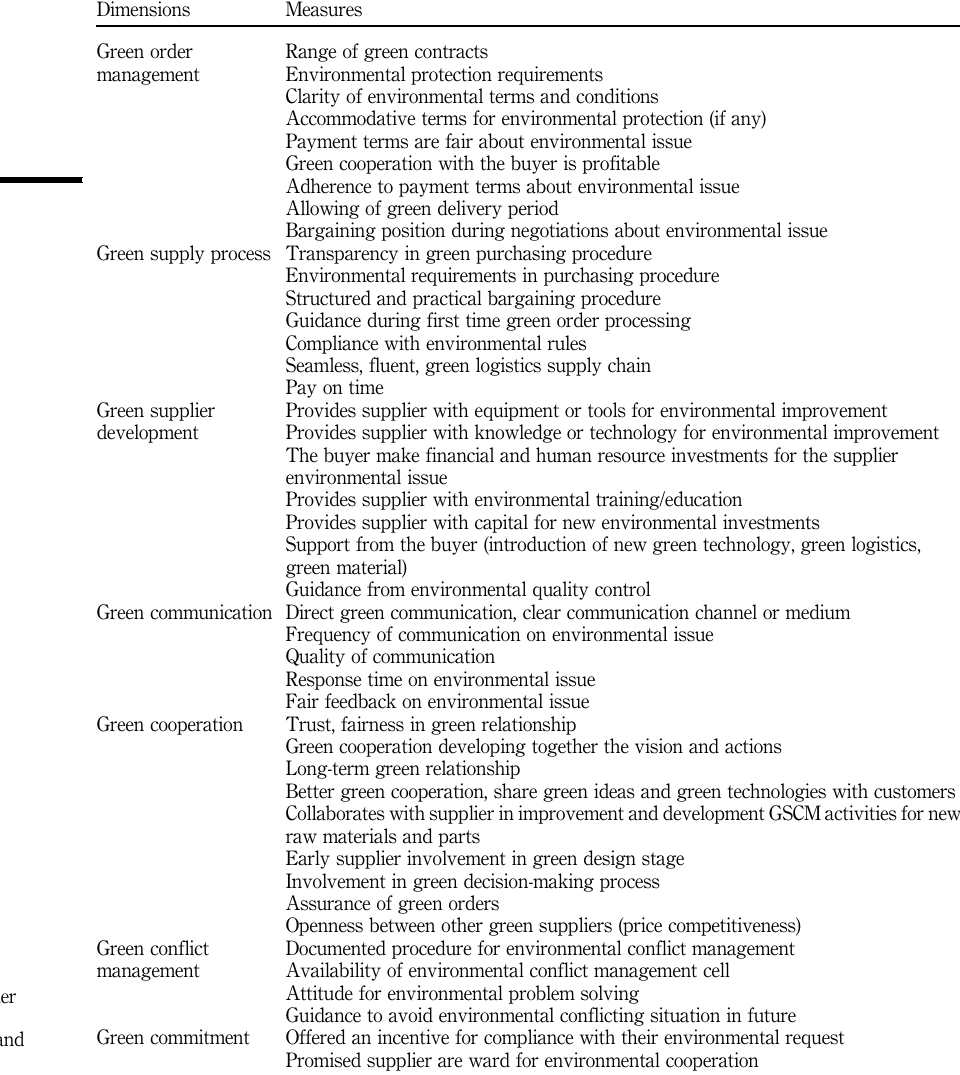
satisfaction dimensions and